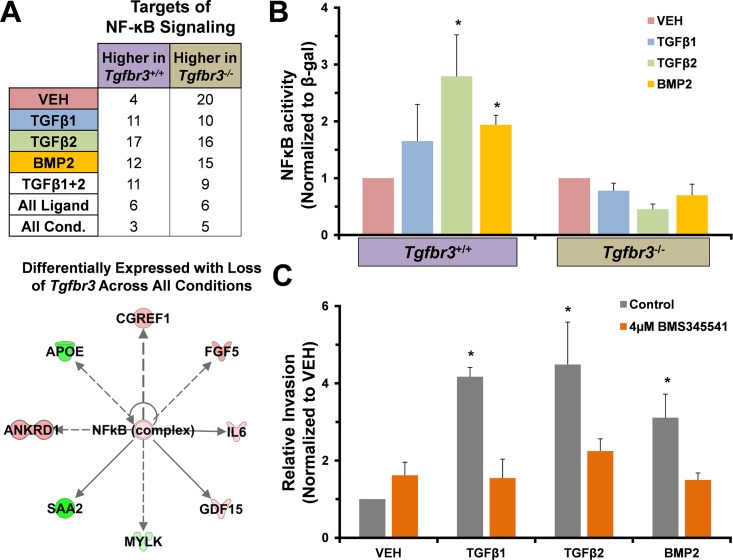
Tgfbr3-/- epicardial cells fail to activate the NF-ĸB signaling pathway.(A) (TOP) Genes dysregulated in each group (>2-fold, p<0.001) were counted. (BOTTOM) Shared targets of NF-ĸB signaling dyregulated in all groups are shown. Red—expressed higher inTgfbr3+/+, Green—expressed higher in Tgfbr3-/-. (B) Cells transfected with an NF-ĸB responsive SEAP reporter construct and incubated with VEH, TGFβ1, TGFβ2, or BMP2 revealed the inability of Tgfbr3-/- cells to induce NF-ĸB signaling. (C) Incubation of Tgfbr3+/+ epicardial cells in a transwell invasion assay with an NF-ĸB inhibitor (BMS345541) significantly reduced invasion (* = p < .01) in response to ligands known to promote Tgfbr3-dependent invasion.